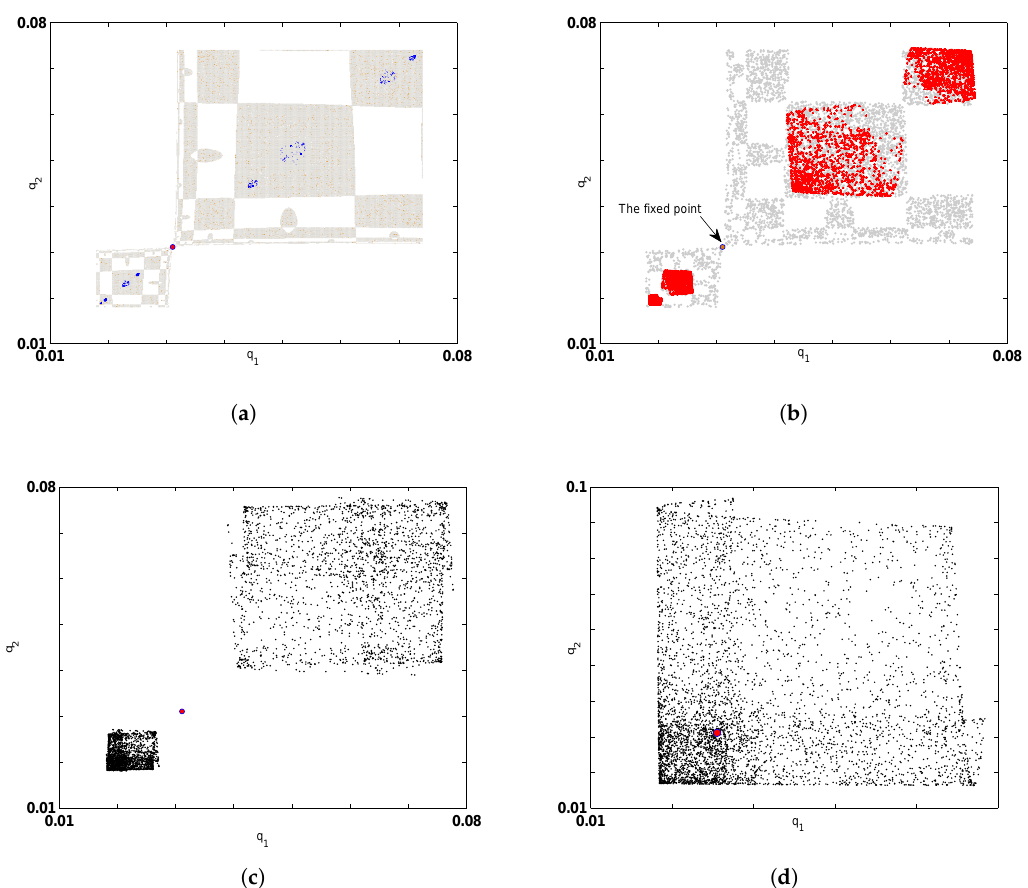
Figure 4. ( a ) Basin of Attraction of 8-band chaotic attractors at k = 28; ( b ) Basin of Attraction of 4-band chaotic attractors at k = 28.1; ( c ) phase portrait of 2-band chaotic attractors at k = 28.4; ( d ) phase portrait of 1-band chaotic attractor at k =